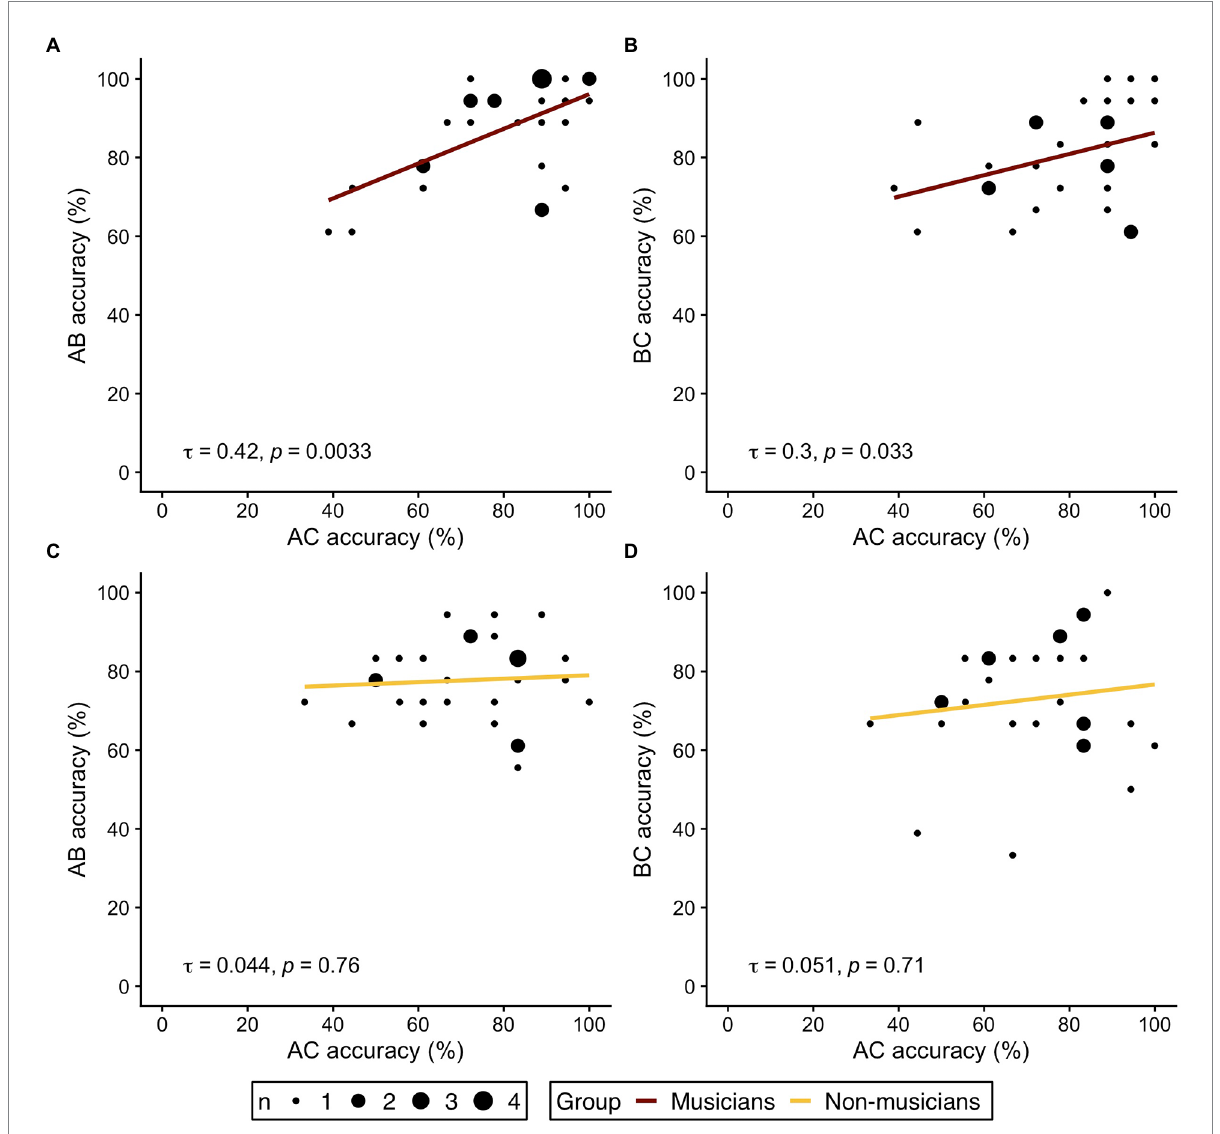
FIGURE 3 Correlations of indirect trials (AC accuracy on the respective x axis) and direct trials (AB, BC accuracy on the respective y axis) in musicians ( A,B , red) and non-musicians ( C,D , yellow). (A,C) Correlation of AC- and AB-trials. (B,D) Correlation of AC- and BC-trials. τ refers to the correlation coefficient from Kendall’s τ . Dot size represent the number of identical